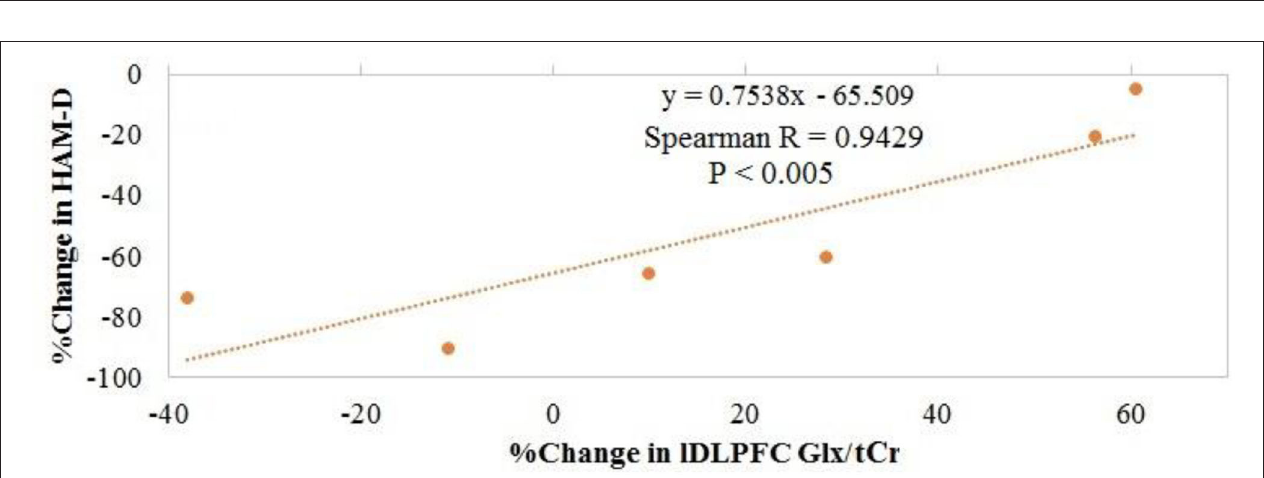
FIGURE 3 | Association between change in glutamate + glutamine (Glx)/total creatine (tCr) in the left dorsolateral prefrontal cortex and change in Hamilton Depression Rating Scale (HAM-D) score.